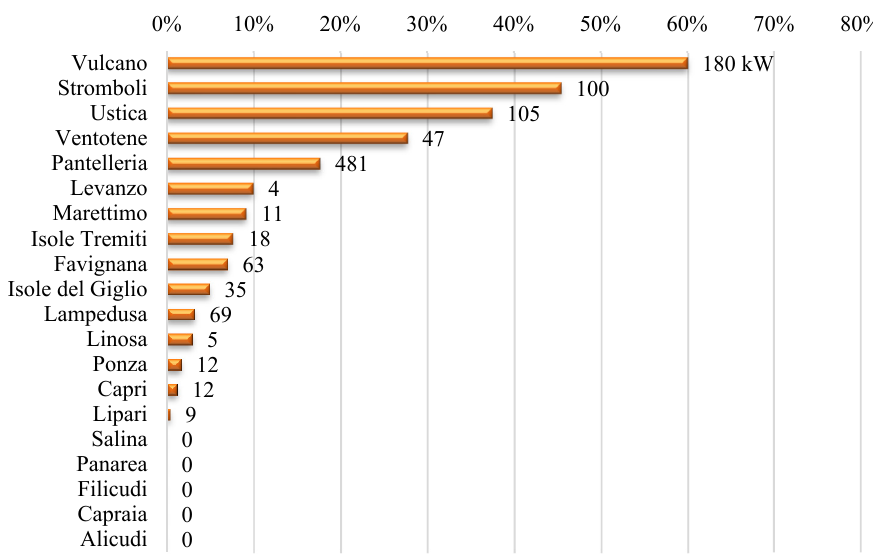
Figure 1. Finalization of target MISE 2020.